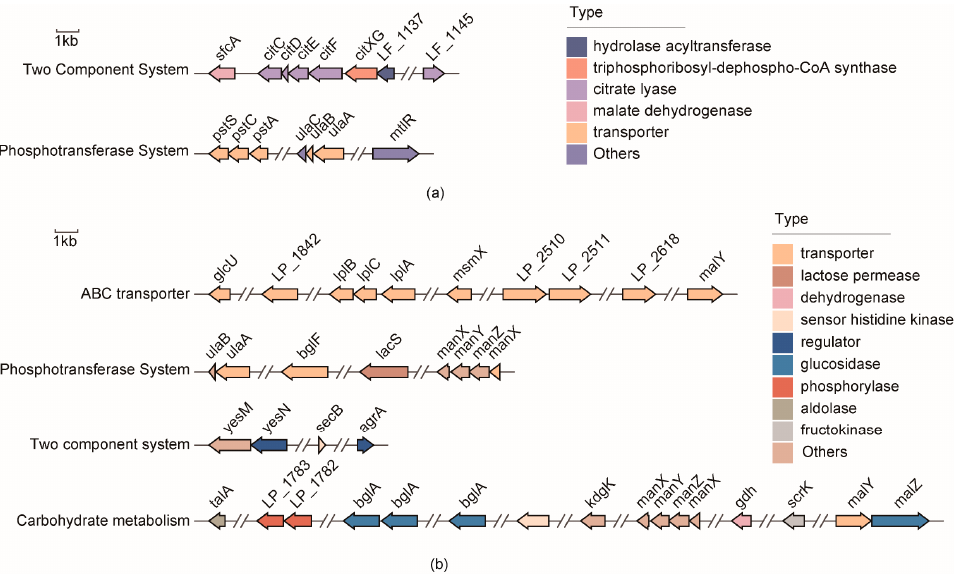
Figure 4. Gene clusters of the functional genes in bile salt-tolerant strains. ( a ) L. fermentum and ( b ) L. plantarum